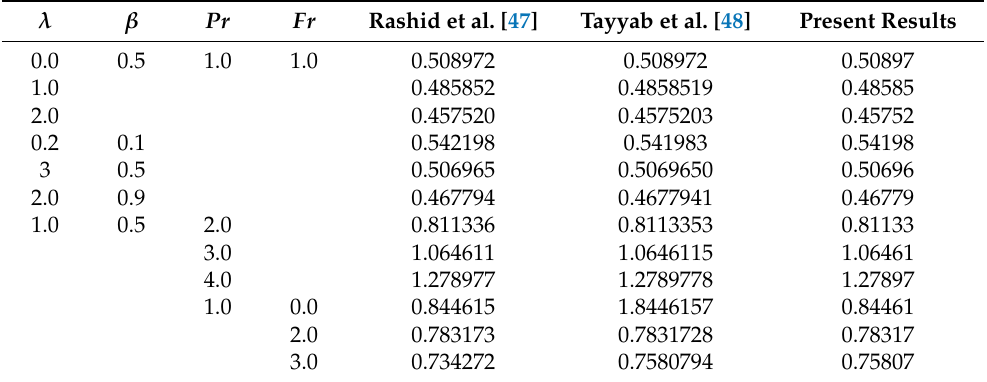
Table 4. Comparison for Nusselt number for different inputs of λ , β , Pr , Fr when ignoring other